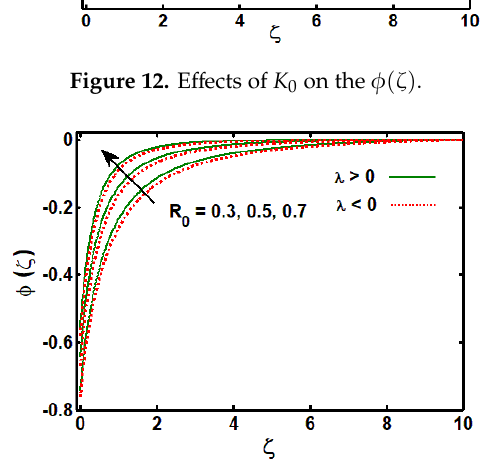
Figure 13. Effects of 𝑹 𝟎 on the 𝝓(𝜻) .